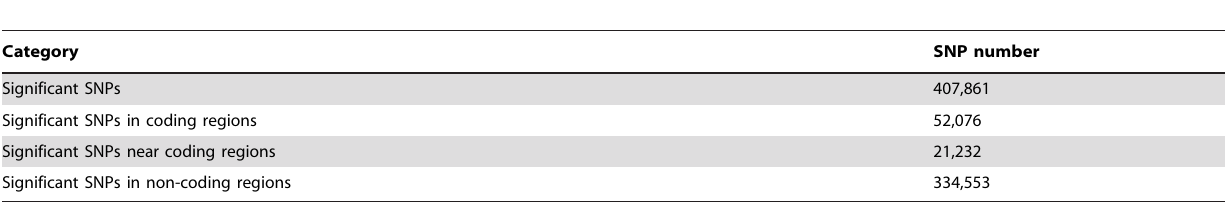
Table 5. Summary of SNPs with significant differences in allele frequencies between four domesticated strains and one wild population in channel